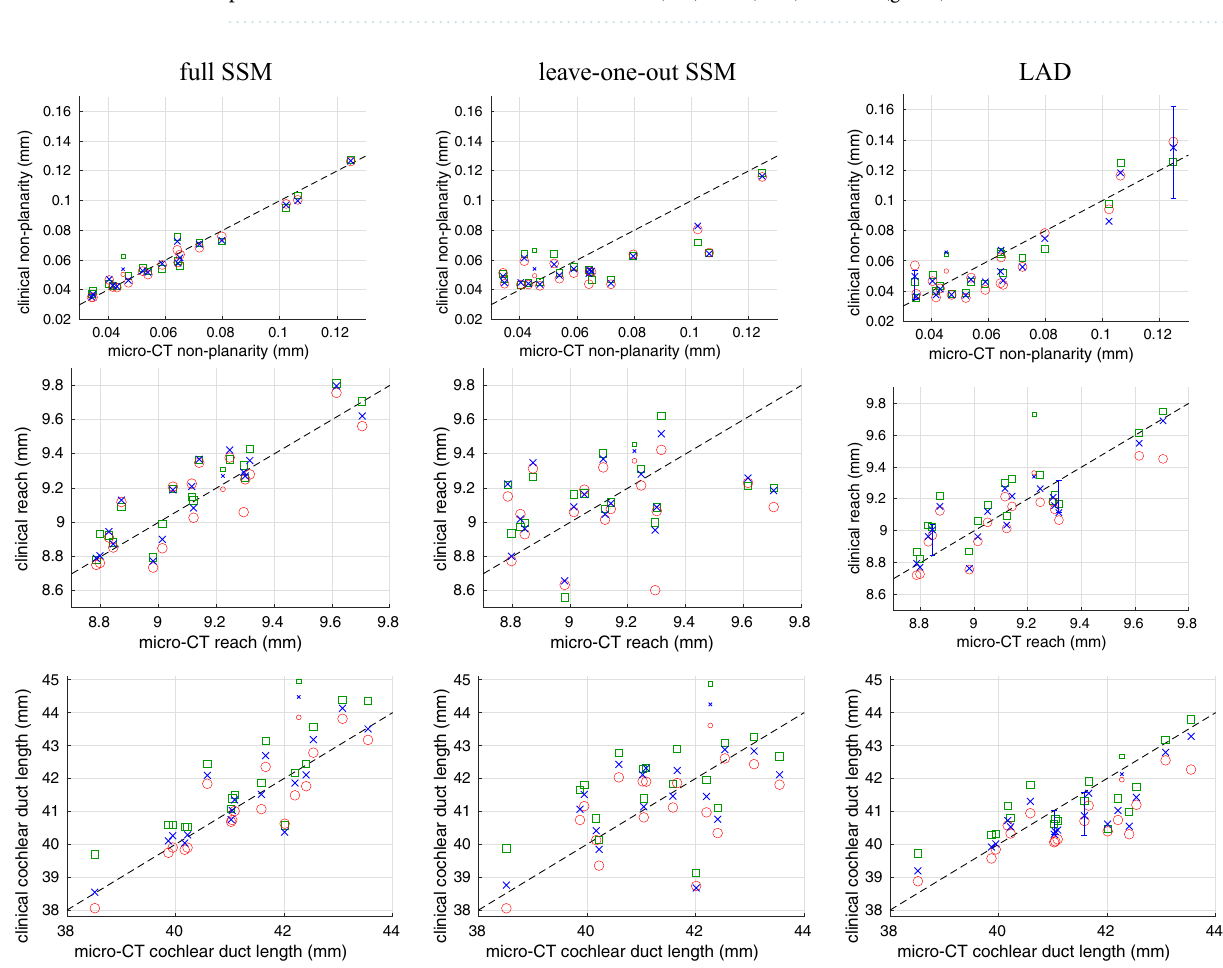
Figure 7. Cochlear non-planarity, reach and duct length estimated from standard pseudo-clinical MDCT. Fully automatic processing with grayscale thresholds of 160 (red circles), 170 (blue crosses) and 180 (green squares). The half-size markers are for the specimen with the implanted electrode. The error bars for the least and most nonplanar cochleas indicate the full range of the results for the LAD sensitivity analyses described in Fig.